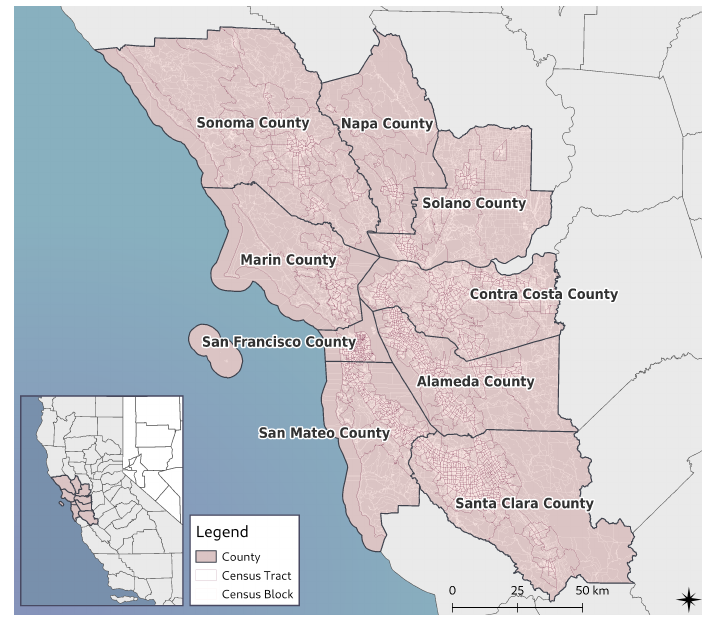
Figure 1. Study area